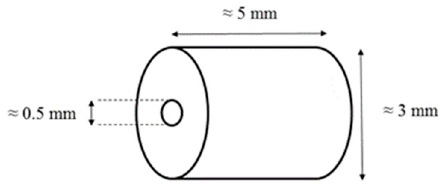
Figure 15. Scheme of the used propellant.